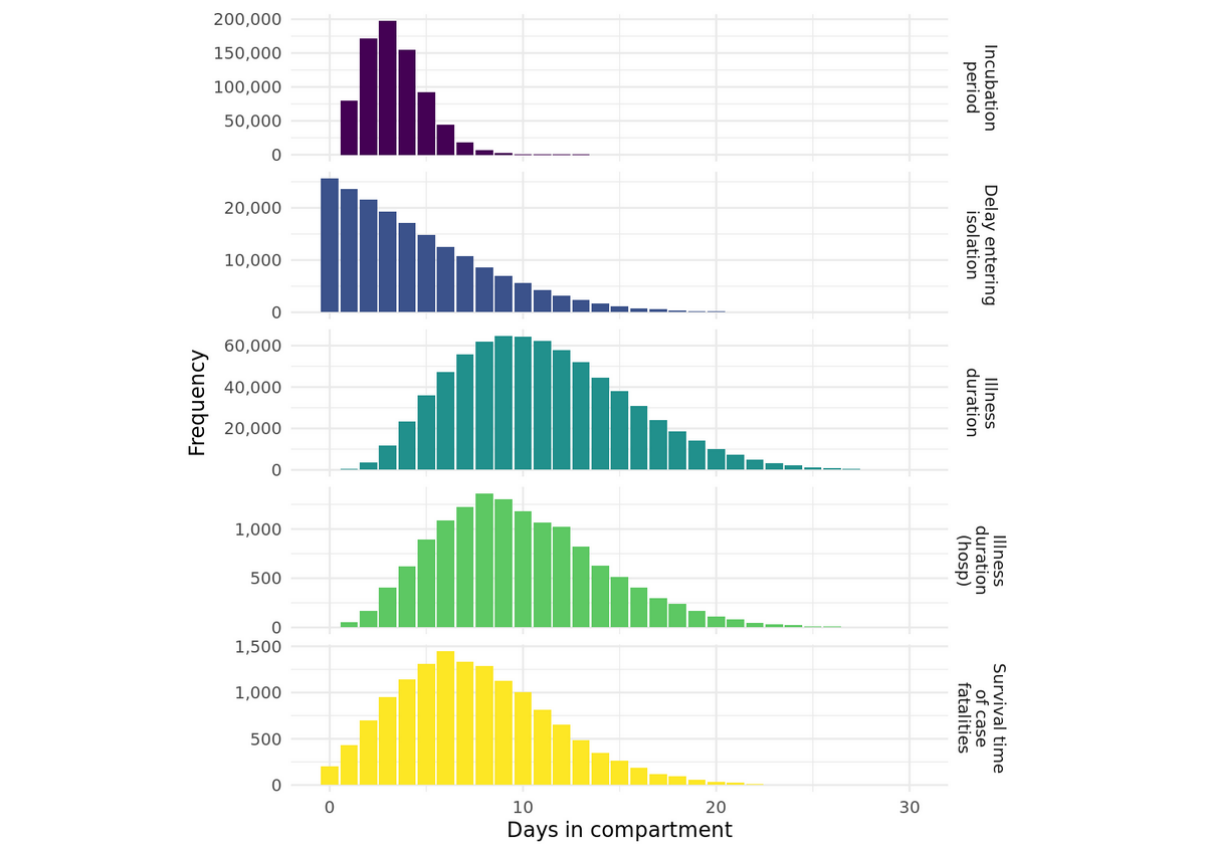
Figure 3. Distributions of time in each compartment in the baseline model. hosp: